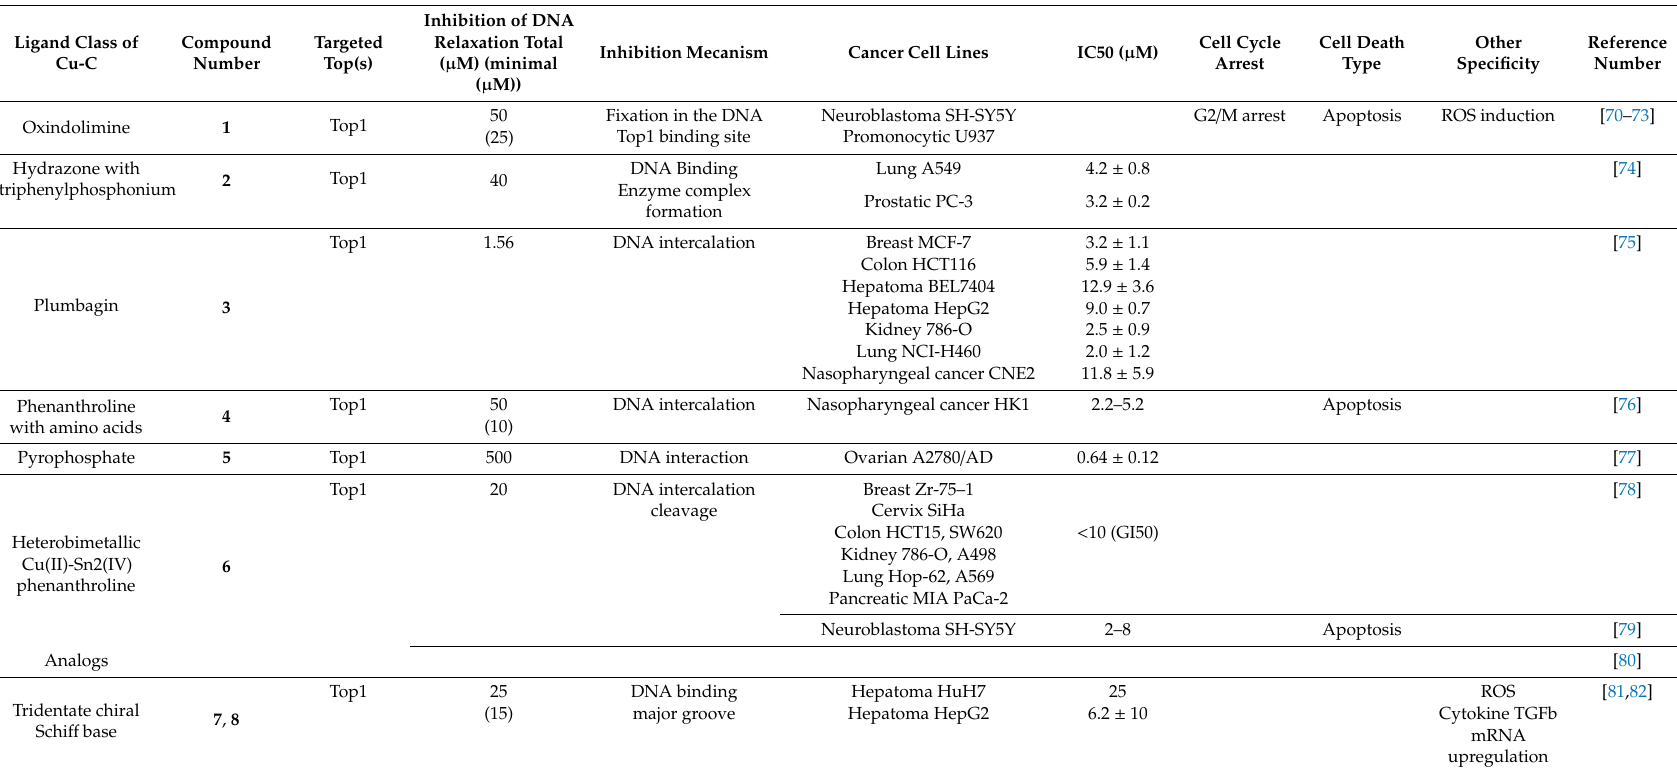
Table 1. Copper complexes inhibitors of topoisomerases: targeted top isoforms, cancer cell lines responses, and molecular mechanisms are summarized. * Tests were realized in vitro with human Top1 or Top2 α / β unless specified. IC50: half-maximal inhibitory concentration. EC50: half-maximal e ff ective concentration. GI50: half-average of growth